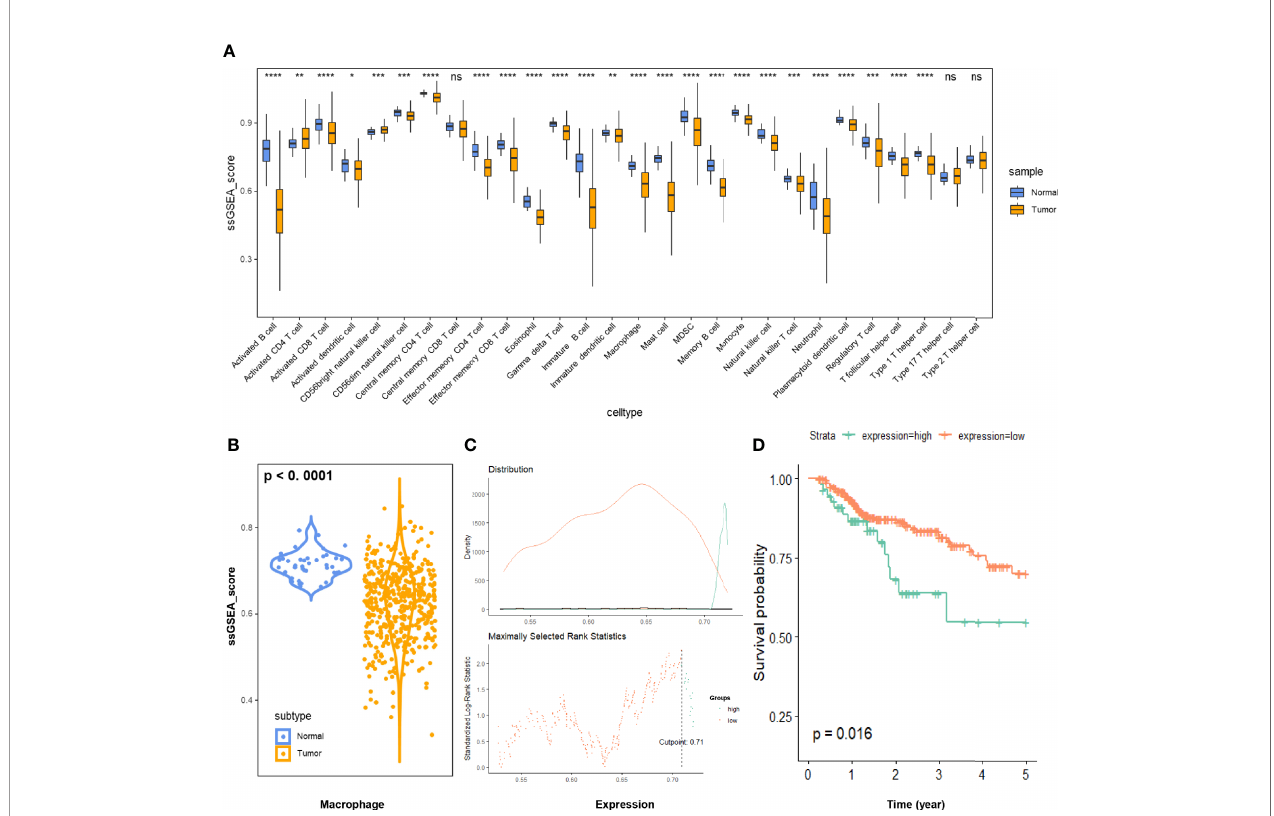
FIGURE 2 | (A) Immune in fi ltration of28 immune cell subtypes was quantitated via the ssGSEA method in473 COADsamples and 41 normal tissue samples. (B) The relative macrophage in fi ltration was signi fi cantly downregulated in COAD tissues (p< 0.0001). (C) Illustration ofthe optimal cutoff point identi fi cation for survival analysis in (D)